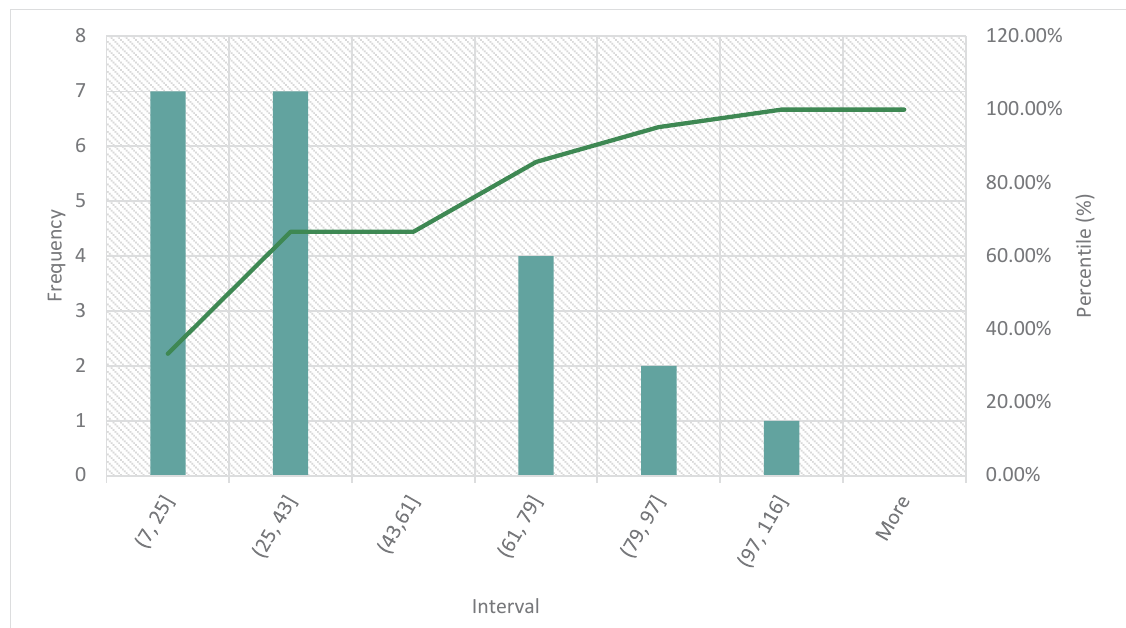
Fig. 8: Histogram and Pareto Graphic for TP in Polk County